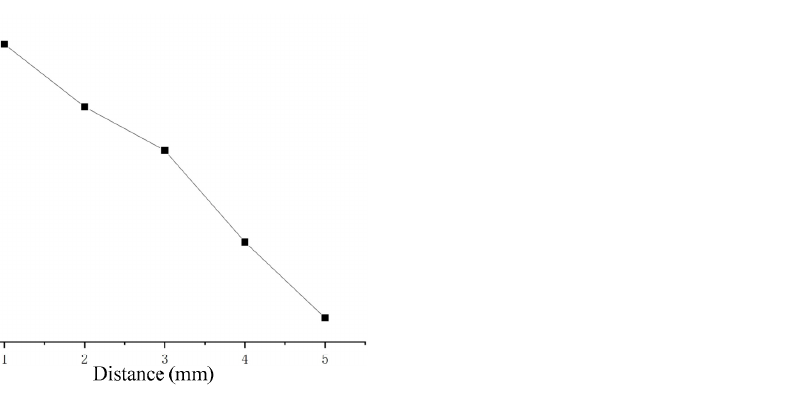
Figure 12. Keyhole depth in Ga–In–An alloy corresponding to different distance of nozzle.